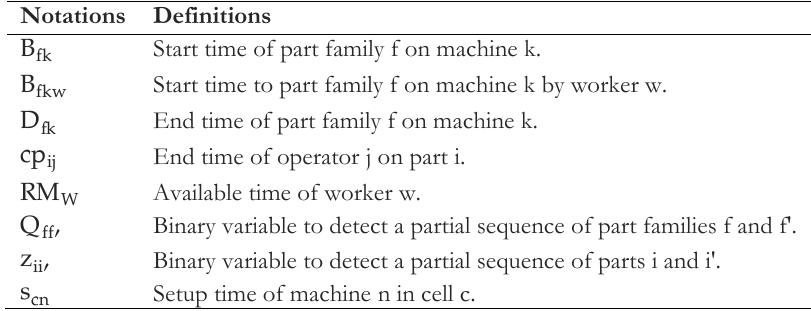
Table 3. Definitions of